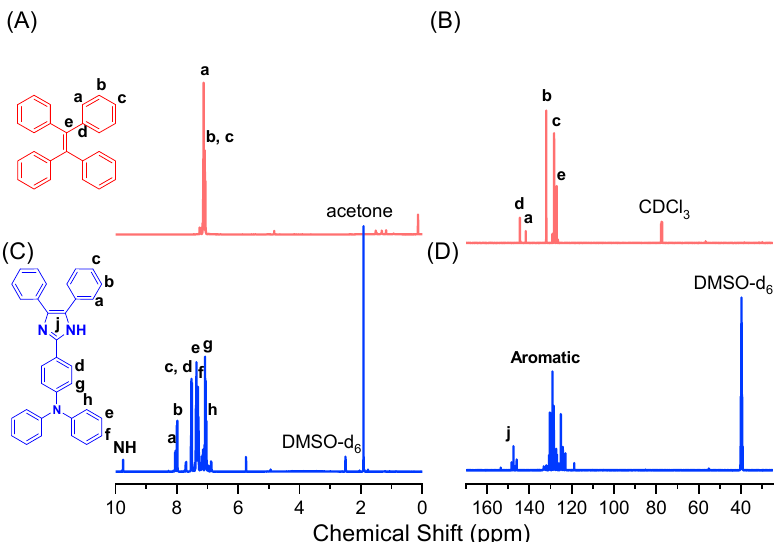
Figure 1. ( A , B ) 1 H-NMR spectra of TPE and DPT. ( C , D ) 13 C-NMR spectra of TPE and DPT.